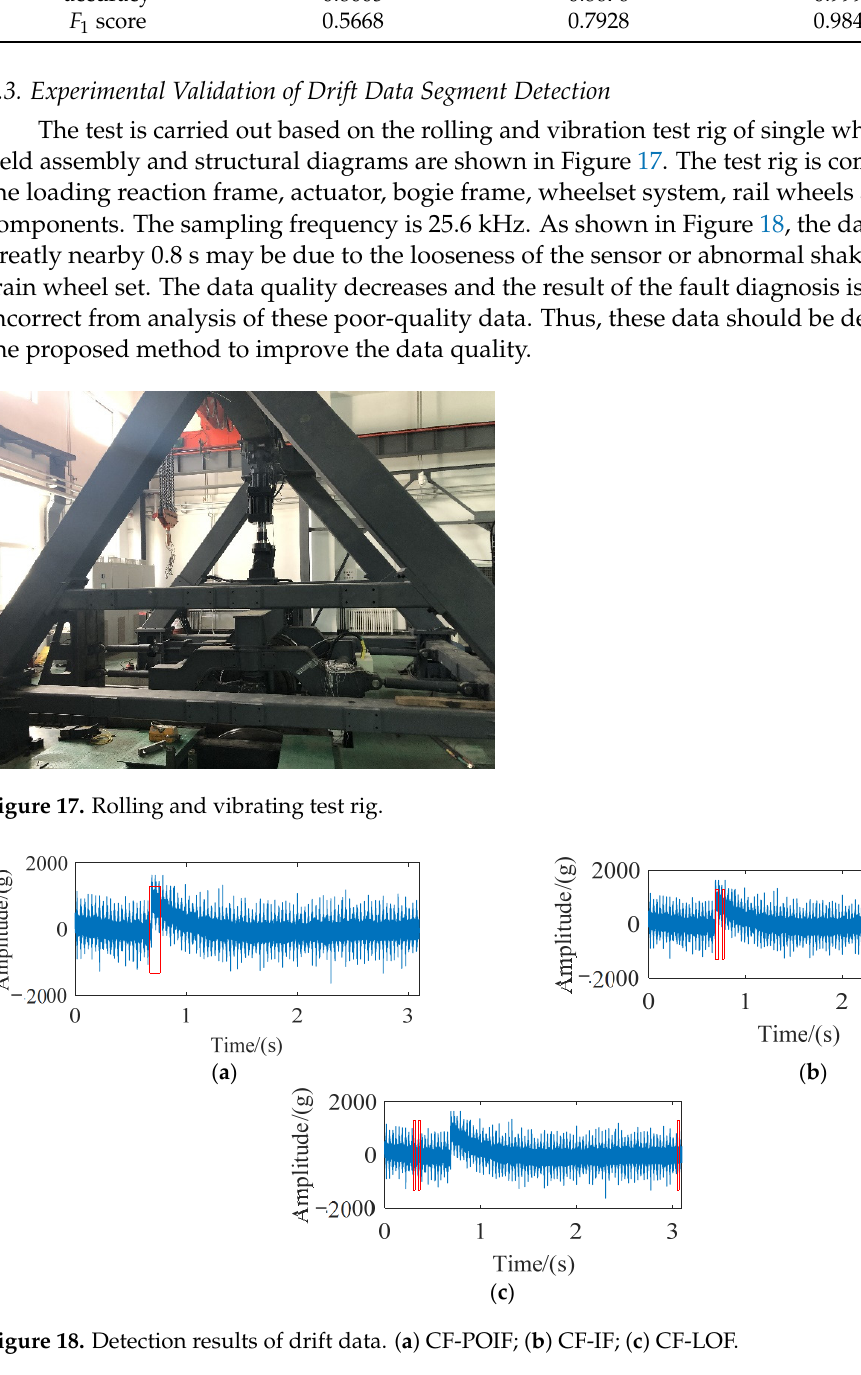
Table 4. Accuracy and F 1 score of fan end signal.